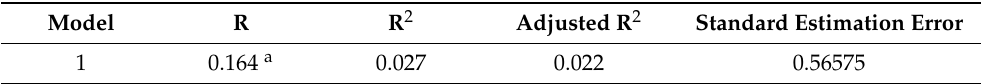
Table 14. Model Summary b .